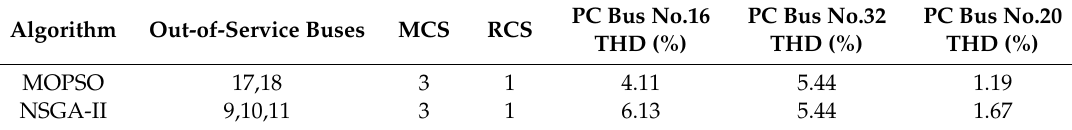
Algorithm-II (NSGA-II) and Multi-Objective Particle Swarm Optimization (MOPSO) algorithm service restoration plan when the fault occurred between bus 7 and 8.